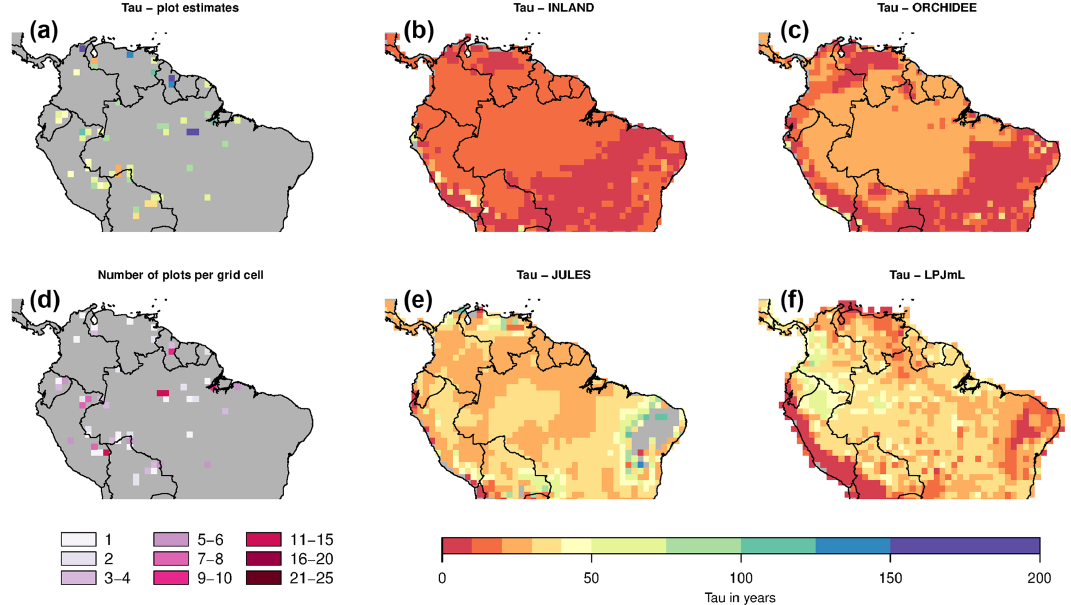
Figure 7. Estimates of woody biomass residence time ( τ) from forest plots in 1 ◦ × 1 ◦ pixels. (b) Mean residence time from inventory plots; (b) number of plots per pixel; and (c–f) simulated τ from four